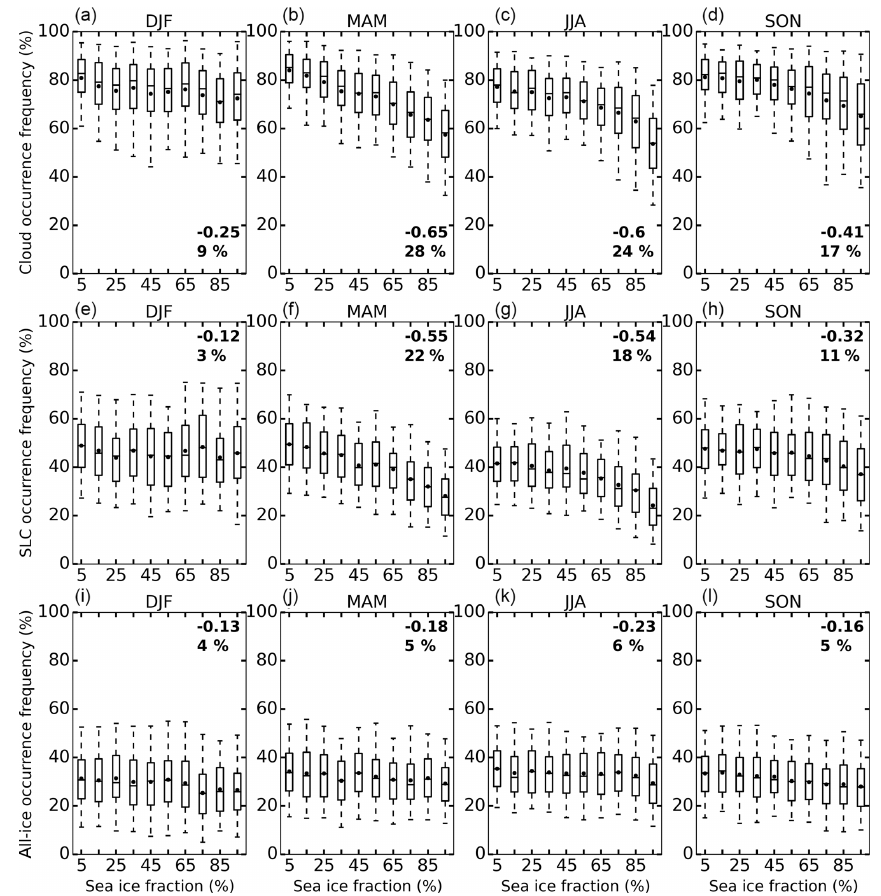
Figure 14. Whisker plots with the median (horizontal lines), the mean (circles), the first and third quartiles and the 5 and the 95 percentiles showing – as a function of the sea ice fraction – the evolution of the low-level cloud fraction (a–d) , the low-level SLC fraction (e–h) and the low-level all-ice fraction (i–l) . The sea ice bin width is 10%, and the centre value of each bin is labelled on the x axis. Each column represents one season. The Spearman’s rank correlation coefficient between the low-level cloud fraction and the sea ice fraction is derived over the whole sample that is used to then compute the whisker plots, and it is indicated at the top-right corner of each panel. The p values for the correlation coefficients are always < 0 . 01. The absolute difference (in %) of occurrence frequency (fraction) of clouds between open water (sea ice fraction < 5%) and sea ice (sea ice fraction > 95%) is indicated below each correlation coefficient.